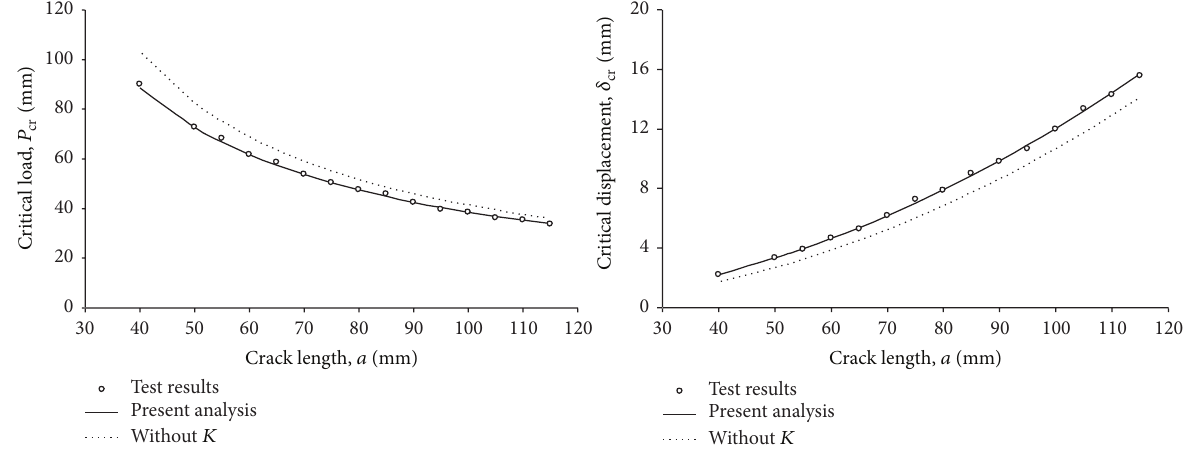
) with ) and the corresponding displacement (𝛿 cr cr